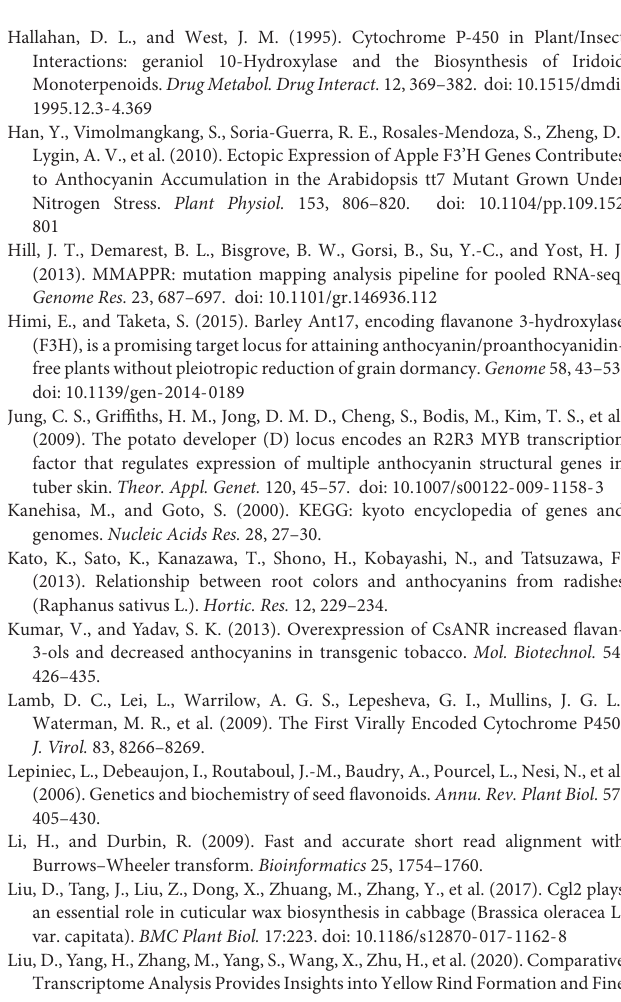
Supplementary Table 2 | Transcriptomic data of the genes within the mapping region. Supplementary Table 3 | Function analysis of the genes within the mapping region. Supplementary Table 4 | PCA of transcriptomic dataset analysis. Supplementary Table 5 | DEGs between ZYR1 and HYR3 with transcriptome